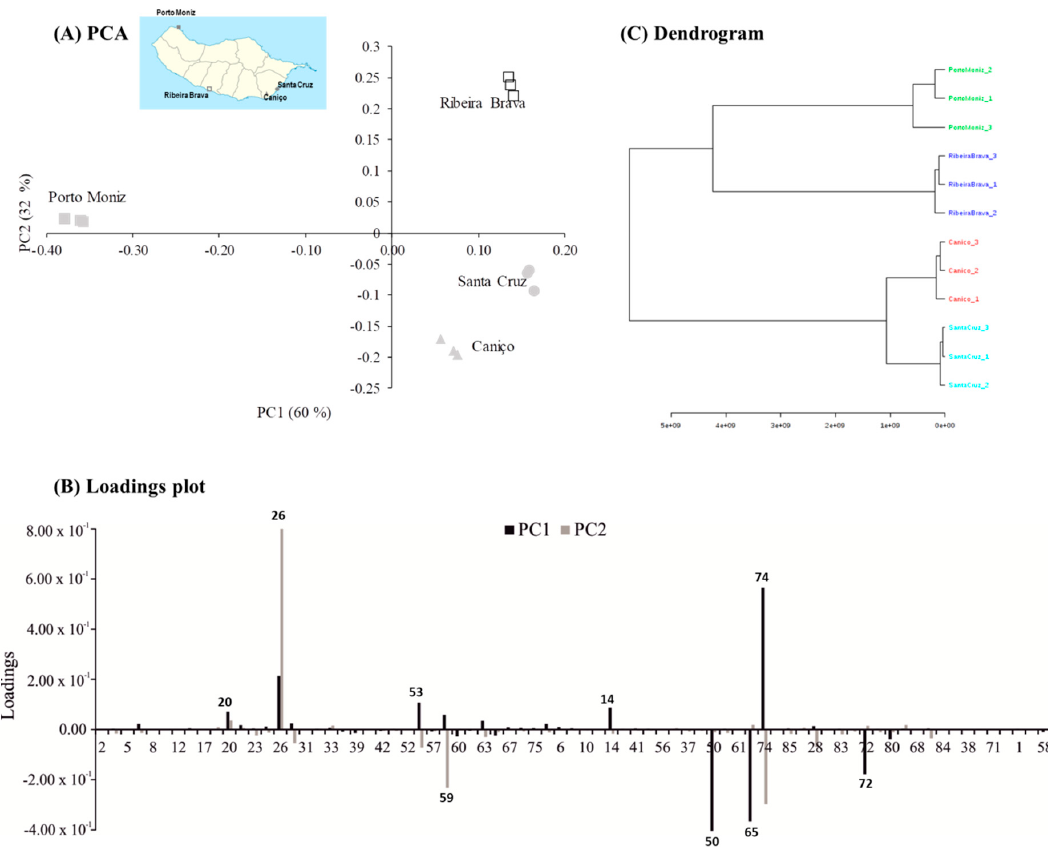
Figure 3. ( A ) Principal Component Analysis (PCA). First principal component (PC1) × second principal component (PC2) of scores scatter plot of Allium cepa L. according to geographical regions; ( B ) loading plot of the main source of variability between volatile profile and Allium cepa L. (attribution of the peak number shown in Table 2); ( C ) dendrogram of a cluster analysis in onions from four regions of Madeira Island (distance measure using Euclidean and clustering algorithm using ward).